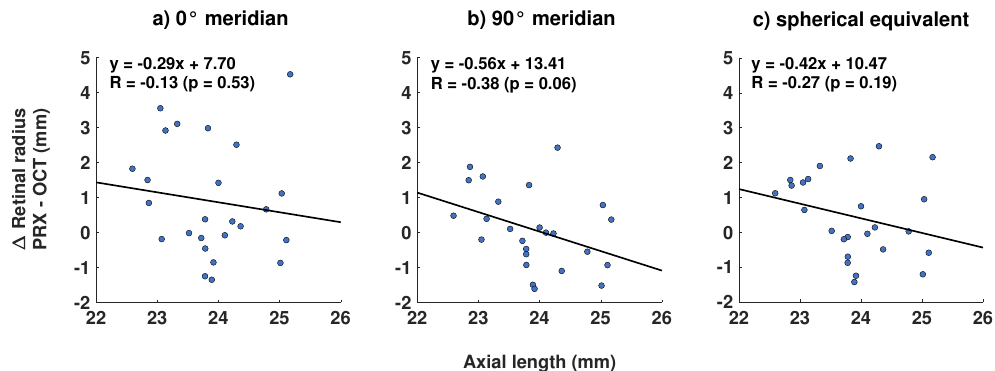
Figure 4. Linear regression equations and coefficients for the relation between axial length and the discrepancy of PRX- and OCT-based retinal radii of curvature ( n =25) for the ( a ) 0 ◦ refractive meridian, ( b ) 90 ◦ refractive meridian, and ( c ) spherical equivalent